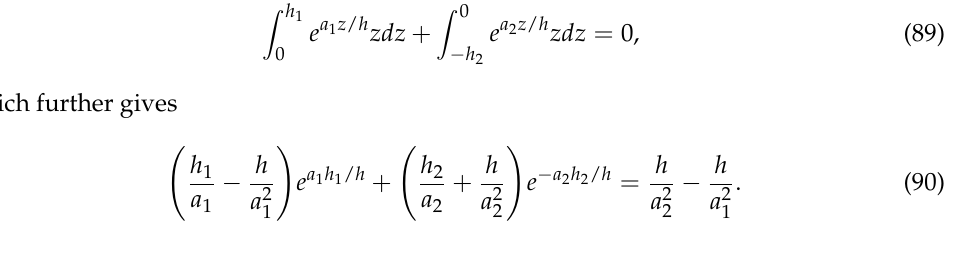
Table 1. Neutral layers in two cases as well as the classical case without bimodular functionally graded property.